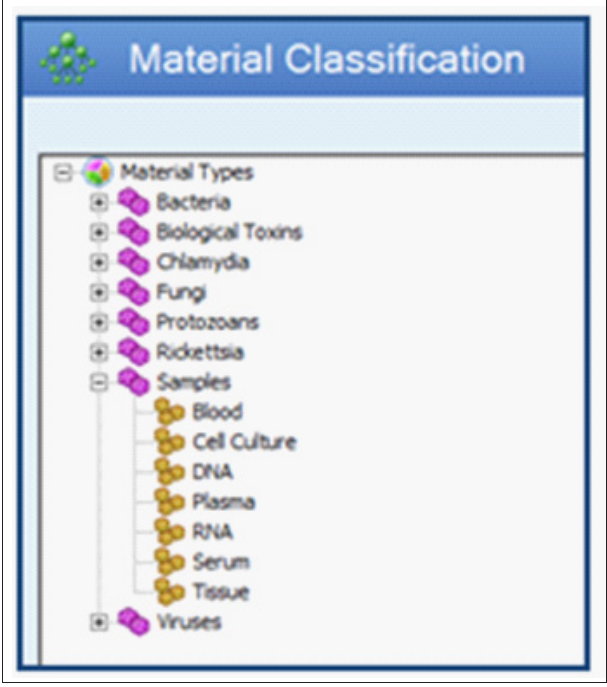
FIGURE 5: Material